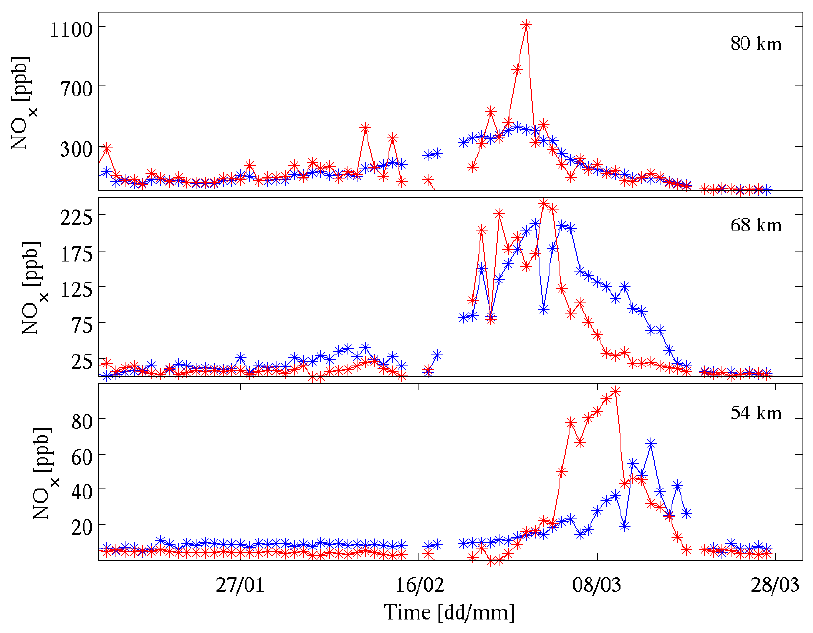
Fig. 6. ACE-FTS NO x observations (red line) and model results (blue line) inppb at 80 (top), 68 (middle) and 54km (bottom) altitudes as a function of time in